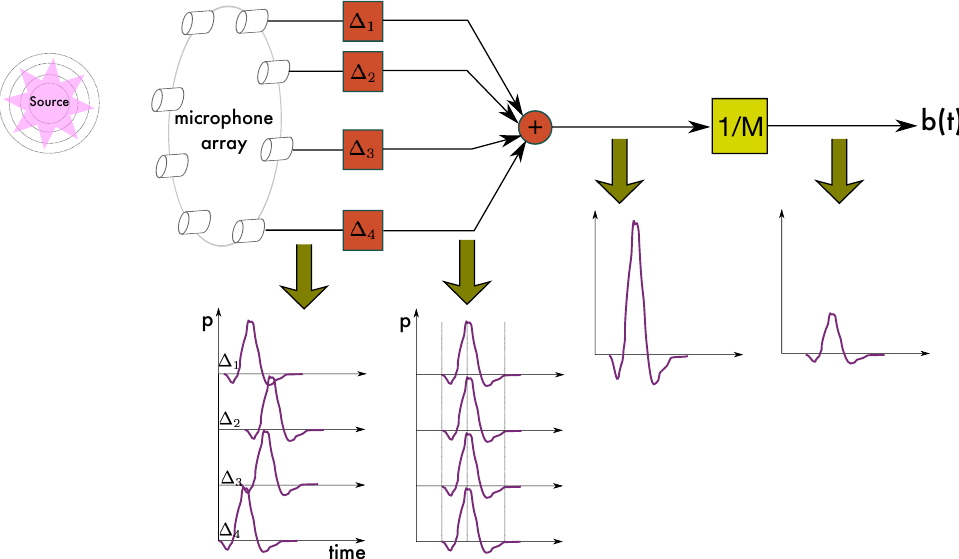
Figure 7. Delay-and-Sum Beamforming. Figure inspired from